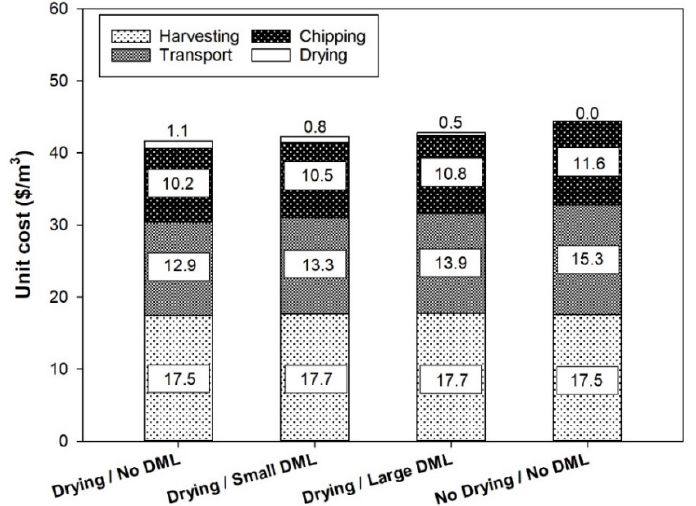
Figure 10. Supply chain costs per m 3 by scenario and activity (harvesting, transport, chipping, and drying).